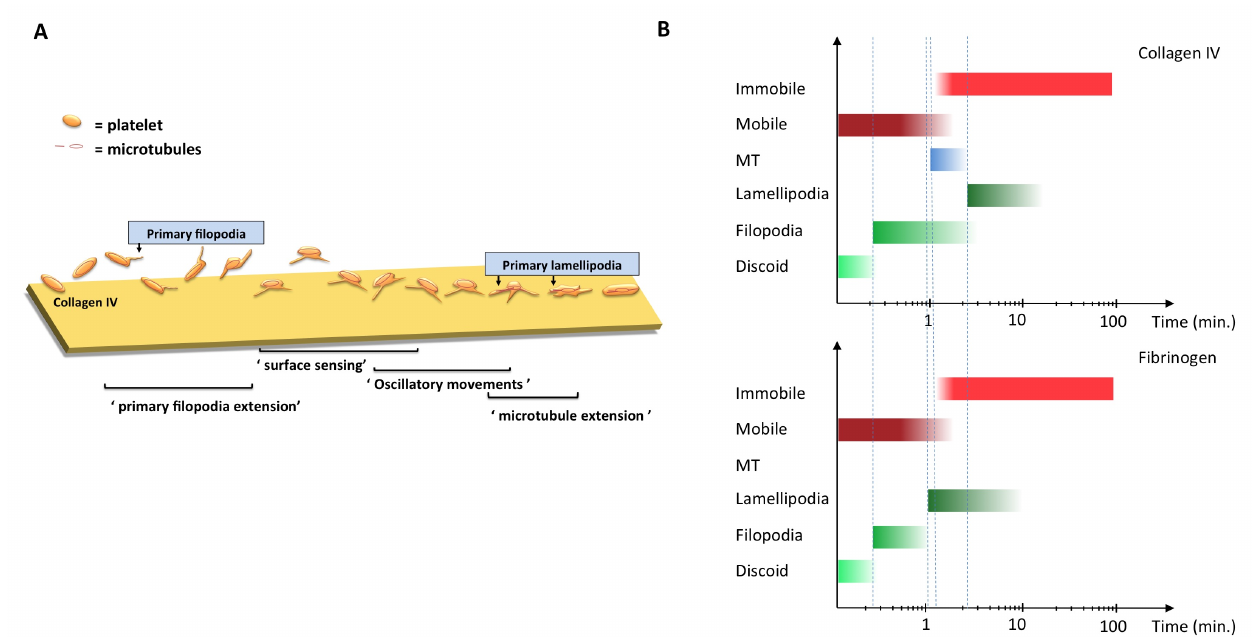
Figure 10. Suggested model for platelet early-stage adhesion. ( A ) The platelet (in orange) on collagen IV surface is floating as discoid shaped with the microtubule coil intact (red), it then extends filopodia while floating, hereby sensing the surface (yellow; collagen IV) and then exhibits oscillatory movements of attachment and detachment. It then attaches and sends out firmly attached protruding filopodia, one of them containing a dominant microtubule extension in the location where we see the primary lamellipodia forming and then continues to spread. On fibrinogen the attachment process would look similar, with the exception of the protruding MT into a filopodia. ( B ) Overview of platelet temporal functional interplay for PLT on collagen IV and PRP-PL on fibrinogen. X-axis shows time, y-axis shows a diverse range of parameters under temporal investigation. Red shades correspond to either a mobile or immobile platelet. Blue indicates microtubule polymerization and the shades of green are the different morphological shapes of the platelet phases: discoid, filopodia and lamellipodial. The gradient illustrates if the certain parameter has more or less over all